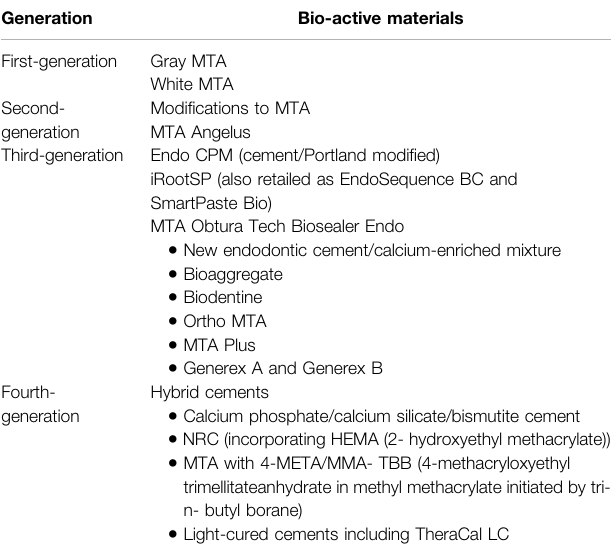
TABLE 1 | Classi fi cation of MTA as bioactive materials (Zafar et al.,